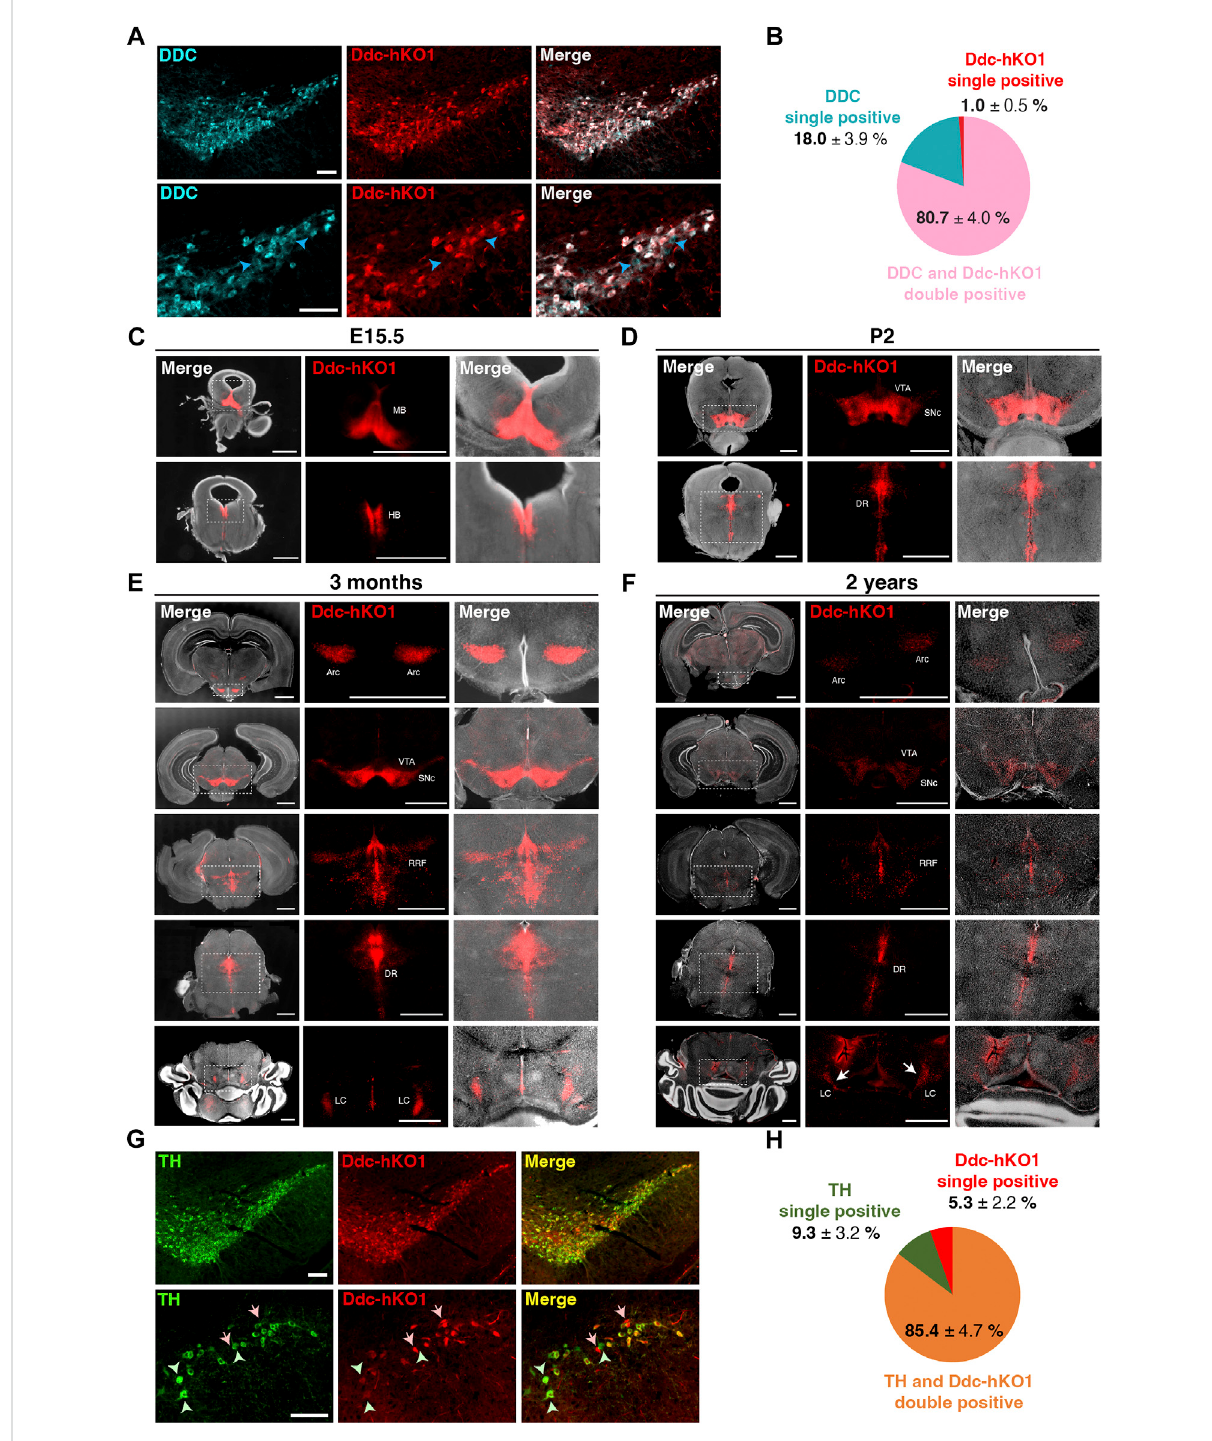
FIGURE 2 Expression pattern of Ddc-hKO1 in embryonic, neonatal, and adult mouse brains. (A) Representative immunostaining images showing the endogenous DDC expression in the VTA and SNc of Ddc-hKO1 homozygous mouse. The enlarged images are shown on the bottom panel. Blue arrowheadsindicateDDC-IFsinglepositivecells.Scalebar:100 μ m. (B) PiechartshowingtheratioofDDC-IFandDdc-hKO1-positivepopulations.± indicates S.E.M. n = 3. (C – F) Representative images of vibratome sections of the whole brain in the coronal plane at E15.5 (C) , P2 (D) , 3 months old (E) and 2 years old (F) of Ddc-hKO1 homozygous mice. Thickness, 200 μ m. Scale bar, 200 μ m. MB, midbrain; HB, hindbrain; VTA, ventral tegmental area; SNc, substantia nigra pars compacta; DR, dorsal raphe nucleus; Arc, arcuate nucleus; RRF, retrorubral fi eld; LC, locus coerules.